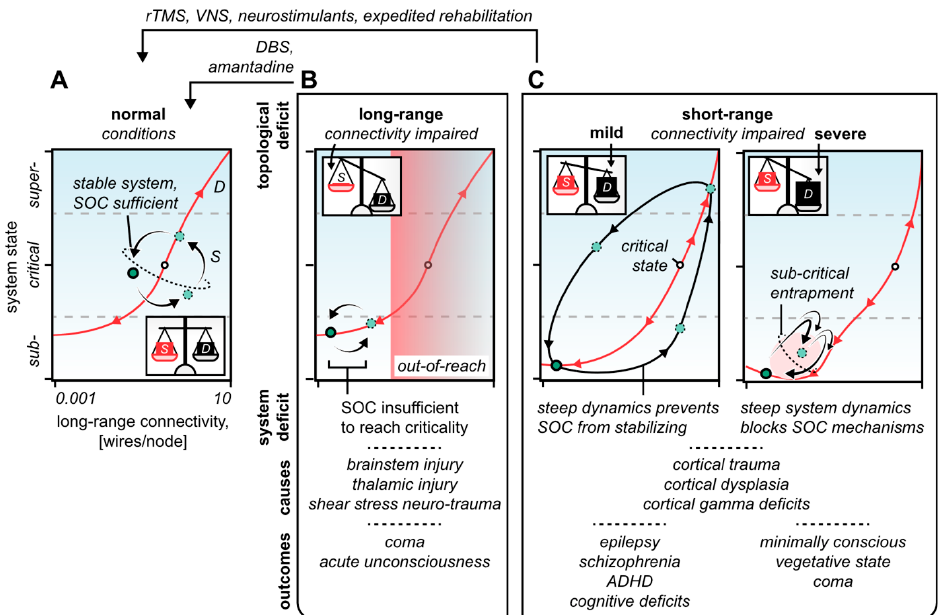
Figure 4. Summary of the hypothesis. ( A ) Under normal conditions, the SOC mechanisms perfectly balance out the system’s topological propensities (see inset). Thus, the system manages to maneuver the critical state to facilitate local (sub-) and global (super-) neurocomputations. ( B ) When long-range connections are impaired, such as by brainstem shear stress, the system’s SOC mechanisms are acutely voided (see inset). This shifts the system toward sub-criticality to an extent that corresponds to the severity of the long-range neuronal injury. Transient loss of consciousness occurs in complete, but reversible, disruption of the long-range neuronal connectivity. In irreversible cases, the extent of long-range injury corresponds to the depth of unconsciousness, ranging from minimally conscious to fully comatose states. Rehabilitation strategies include thalamic neuromodulation, e.g., through DBS or neurostimulant pharmacotherapy, to augment the thalamocortical loop interactions. ( C ) When short-range connections are impaired, such as by a neuro-traumatic cortico-dysfunction, the system’s topological propensities are intensified (see insets). In mild cases, this makes the system fluctuate between extreme dynamical regimes because the SOC mechanisms fail to stabilize near the critical state. In severe cases, the system is effectively trapped in a sub-critical trough in which SOC is com- pletely blocked by the system’s now intense topological propensities. Potential therapeutic strategies include repeated TMS to potentiate cortical short-range connectivity or expedited acute rehabilitation to reduce neuroplastic synaptic depression in neuro-traumatic patients. S, SOC mechanisms; D, the system’s topological propensities; rTMS, repeated transcranial magnetic stimulation; VNS, vagus nerve stimulation; DBS, deep brain stimulation; ADHD, attention deficit hyperactivity disorder. Insets show the balances between the system’s SOC mechanisms and its topological